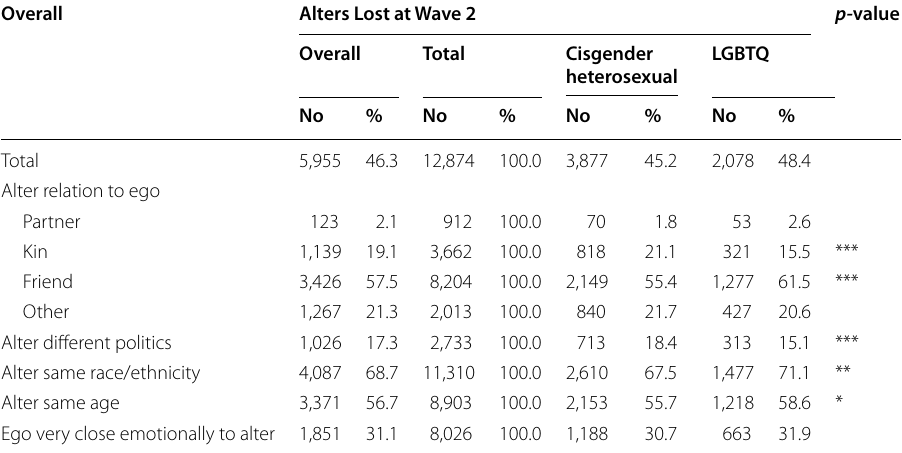
Table 3 Characteristics of alters who were lost at Wave 2, by respondent sexual orientation/gender identity,